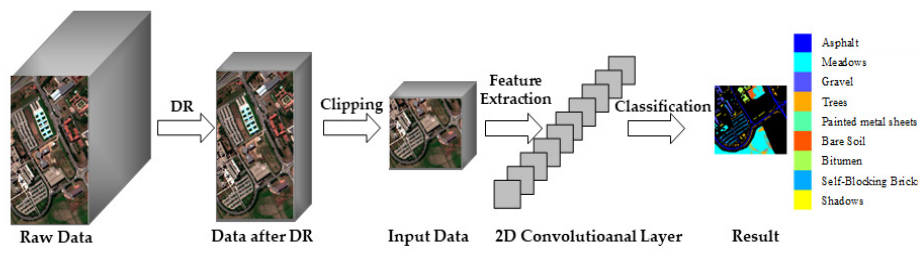
Figure 1. HSI Classification Based on